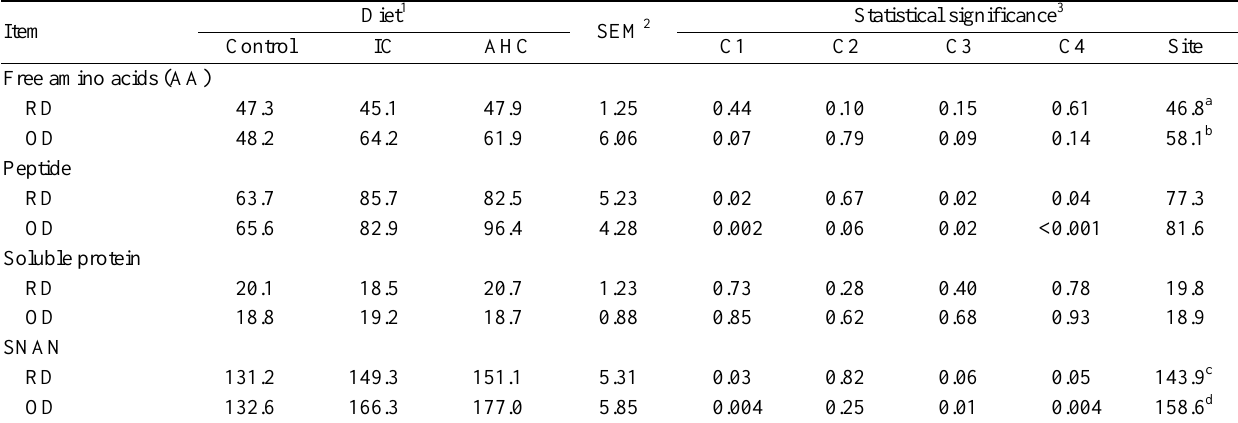
Table 3. Effect of soluble protein supplements on concentration (mg/L) of soluble non-ammonia nitrogen fractions in ruminal (RD) and omasal digesta (OD) of Korean native steers